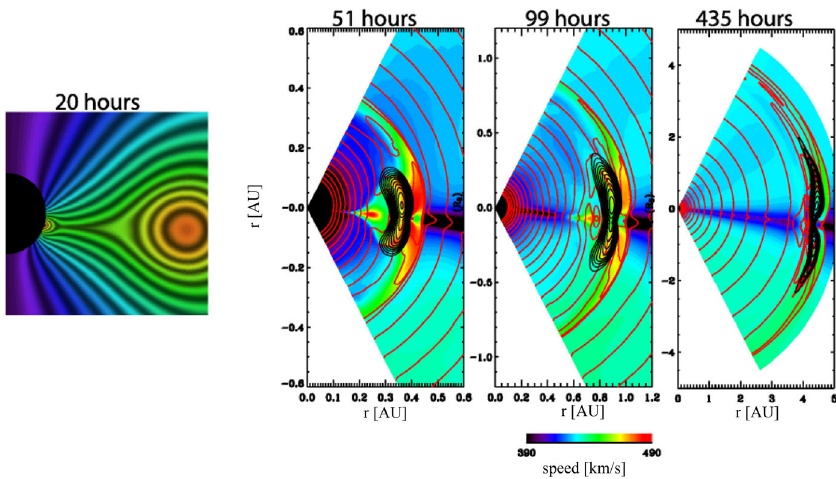
Fig. 9 Snapshot of the CME evolution for an MHD simulation at four different times. The colour map shows the radial velocity, the black contours the magnetic flux, and the red contours the number